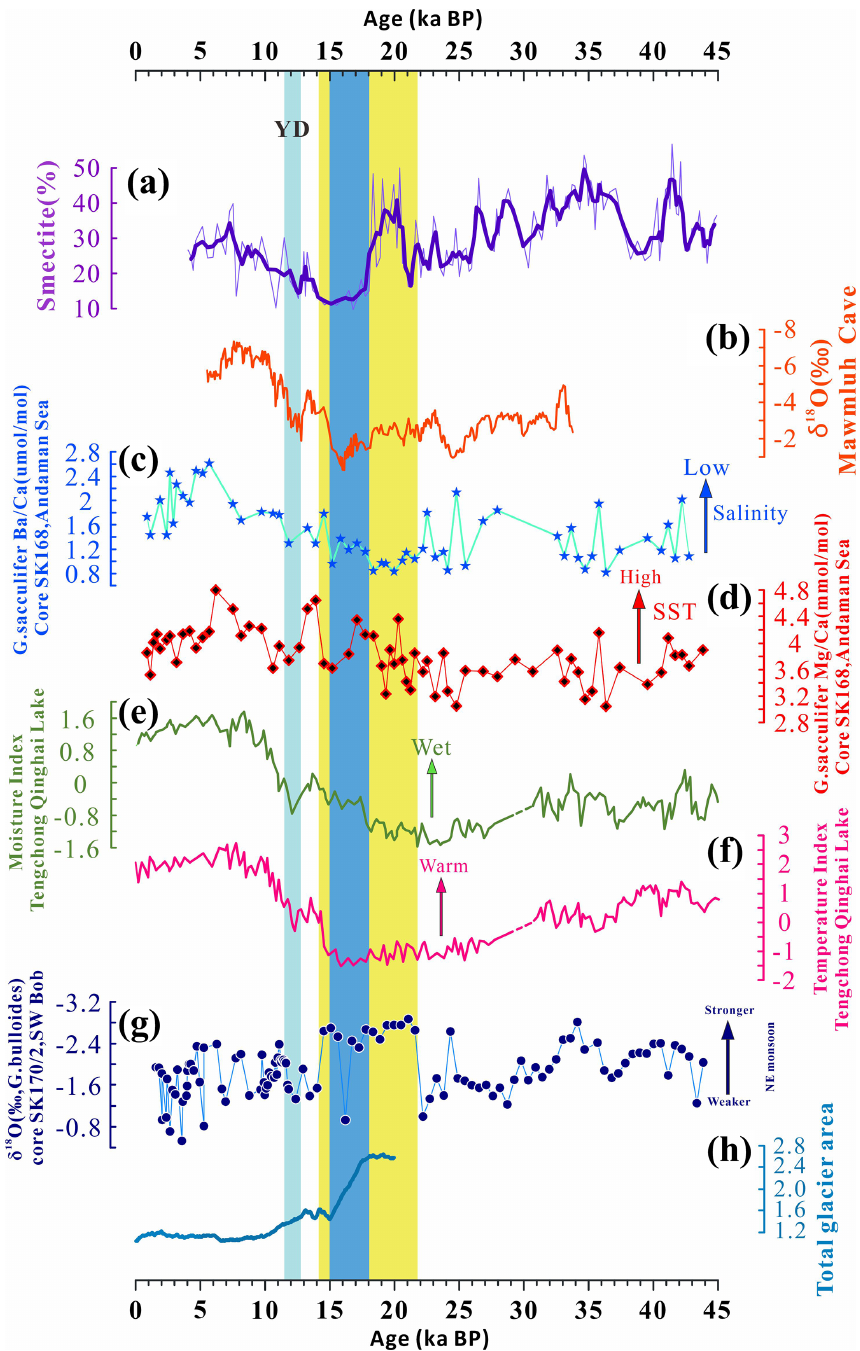
Figure 6. Comparison of smectite percentages in core 17I106 with paleoclimate records. (a) Smectite percentages in core 17I106 (thick line represents a 3-point running average); (b) Mawmluh Cave δ 18 O record for the interval 33800 to 5500 years BP (Dutt et al., 2015). (c, d) Ba / Ca and Mg / Ca of the mixed layer species G. sacculifer in core SK 168 from the Andaman Sea, which represent the sea surface salinity and temperature; the lower salinity and higher temperature showed a strong SW monsoon (Gebregiorgis et al., 2016). (e, f) Moisture index and temperature index from pollen records from Tengchong Qinghai Lake (Peng et al., 2019; Zhang et al., 2020). (g) δ 18 O variability record of planktic foraminifera Orbulina universa obtained from core SK 170/2 recovered from the southwestern Bay of Bengal, which represents the strength of the NE monsoon (Gautam et al., 2020). (h) Ratio of the modeled total glacier area over the southern parts of the Himalayan–Tibetan orogen to the present level (Yan et al., 2020). Yellow, blue, and cyan bars represent the strong NE monsoon period shown in (g) , the main periods of glacier melting in the southern Himalayas shown in (h) , and the cold-climate periods of the Younger Dryas (YD).